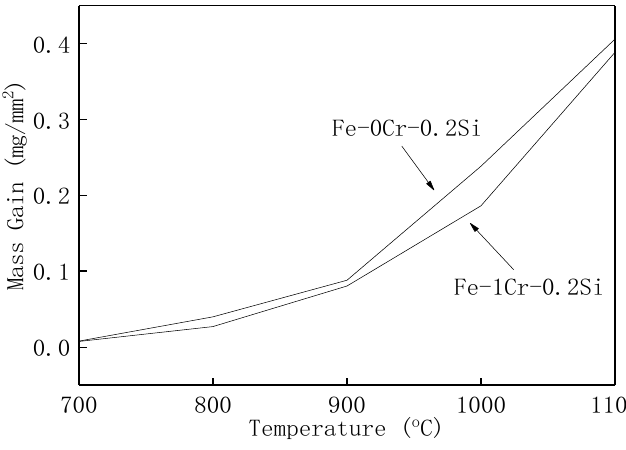
Figure 4. Increase in weight gain for two types of steel after 120 min of oxidation.